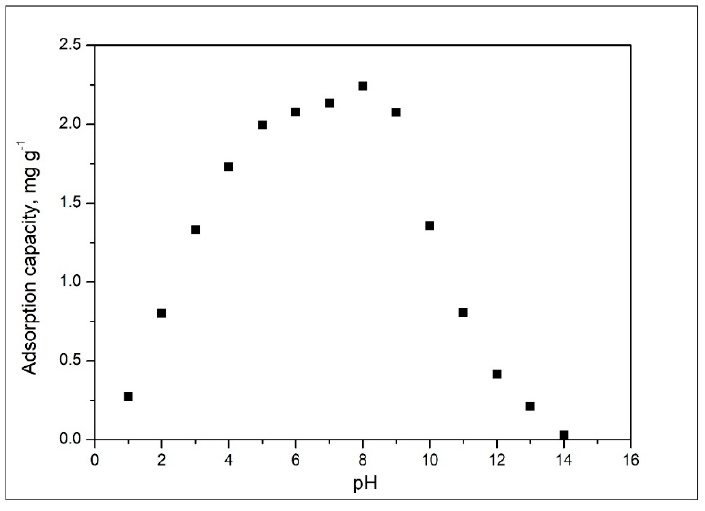
Figure 8. pH effect on adsorption capacity.